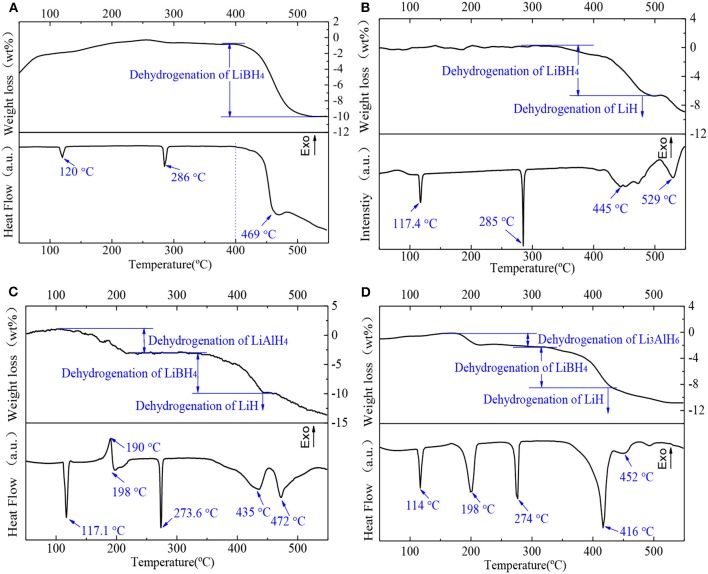
DSC/TG curves of (A) pure LiBH4, (B) 2LiBH4-Al, (C) 2LiBH4-LiAlH4, and (D) 2LiBH4-Li3AlH6 samples after ball milling for 1 h.